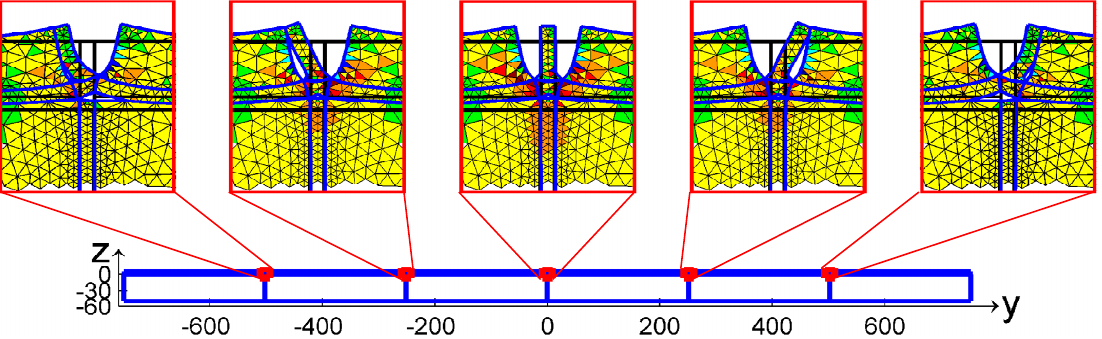
Figure 6. Details of the detachments on the joints of the tiles due to temperature variation.